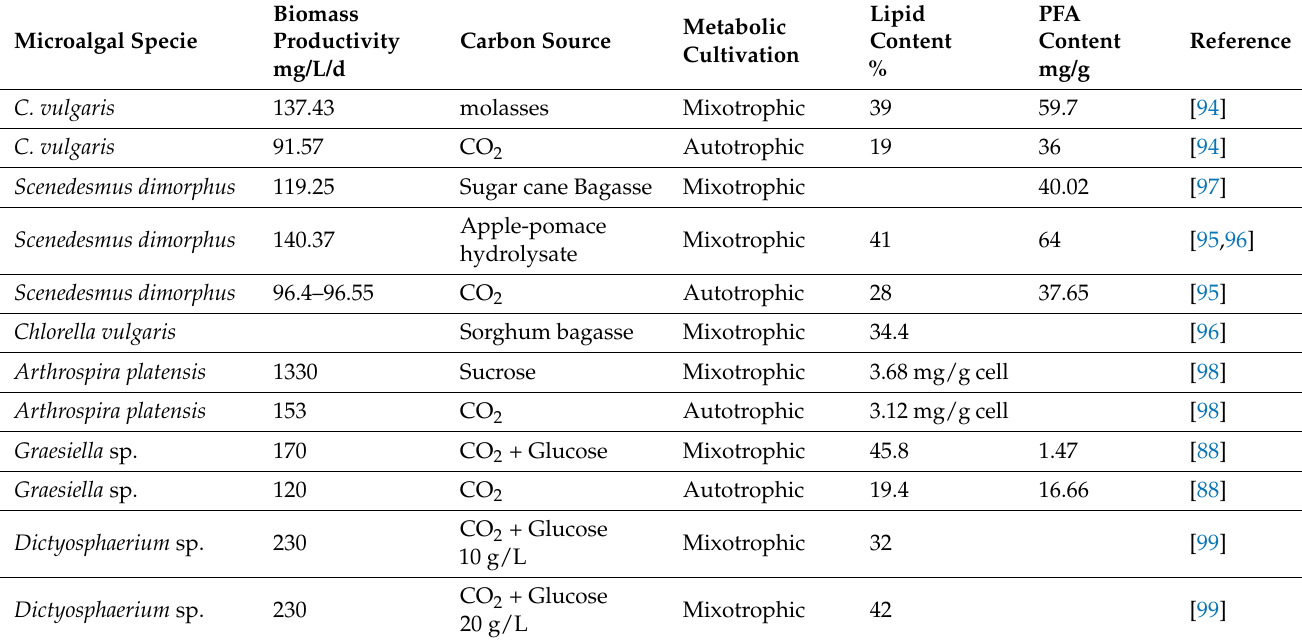
Table 5. Biomass and lipid productivity under different production